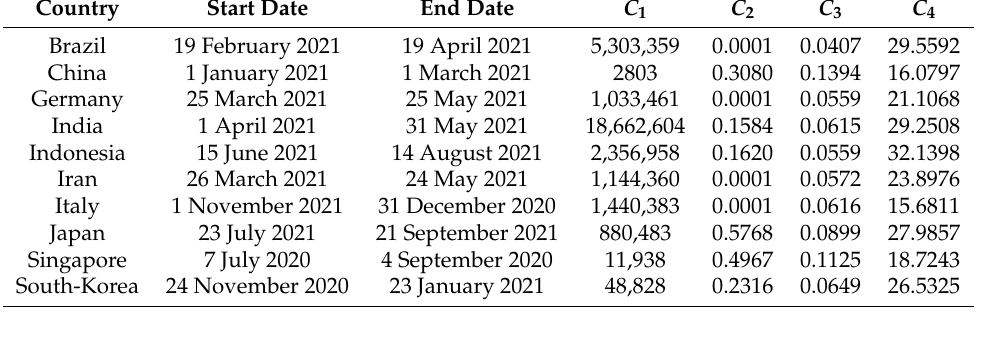
Table 4. Parameter estimation of the cumulative dynamics using GLGM for the second transmission.